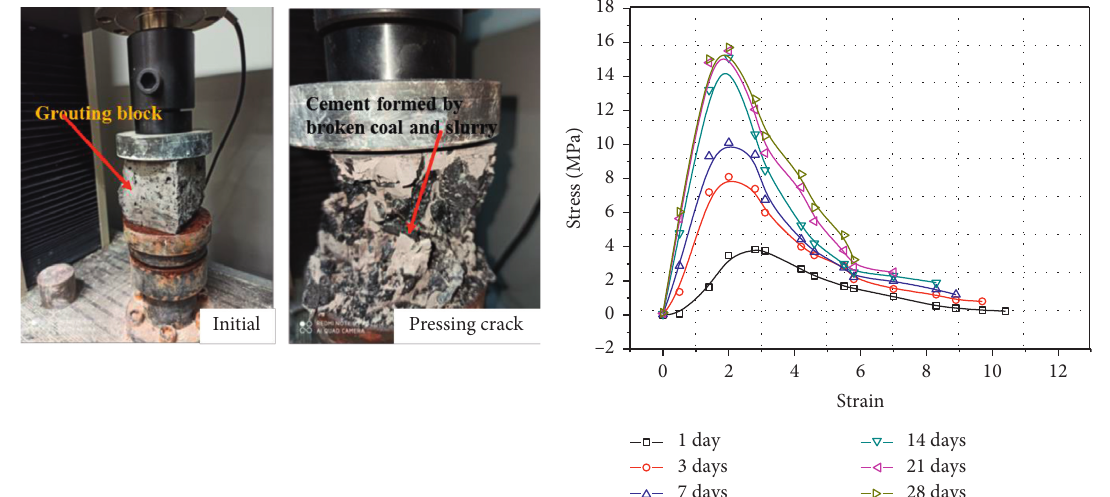
Figure 23: Uniaxial compression test of laboratory grouting block strength.